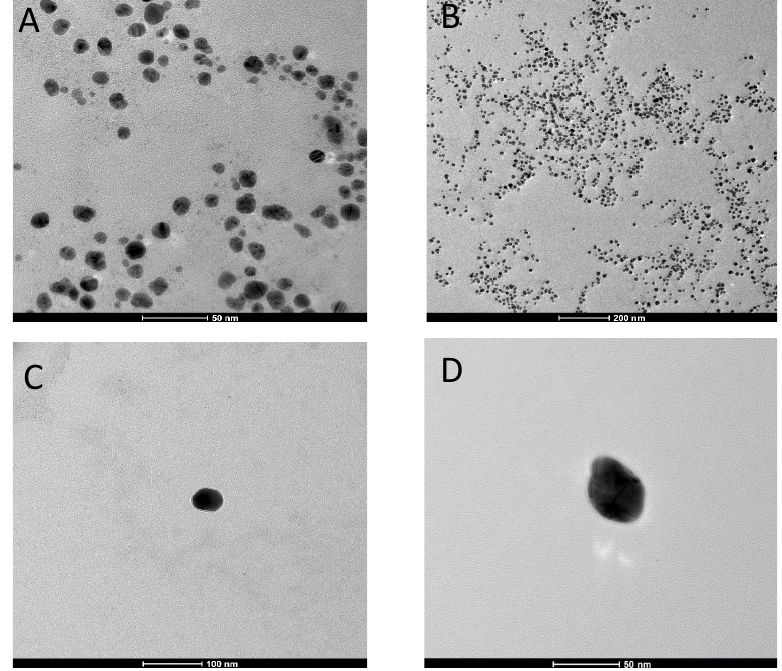
Figure 5. Transmission electron microscopy analysis of synthesized AgNPs ( A , B ) and CH ‐ AgNPs ( C , D ).